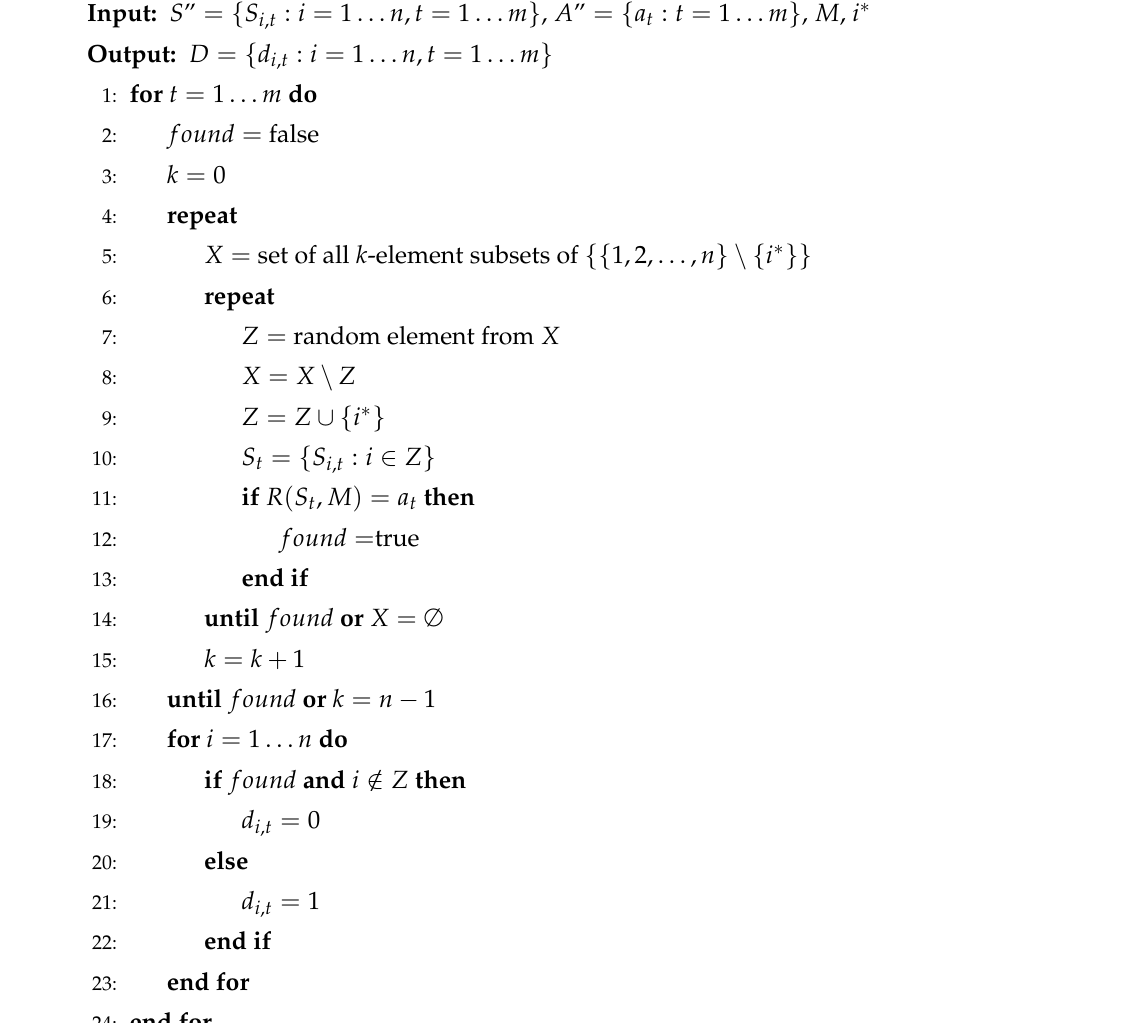
Algorithm 3 Data preparation for training of models M